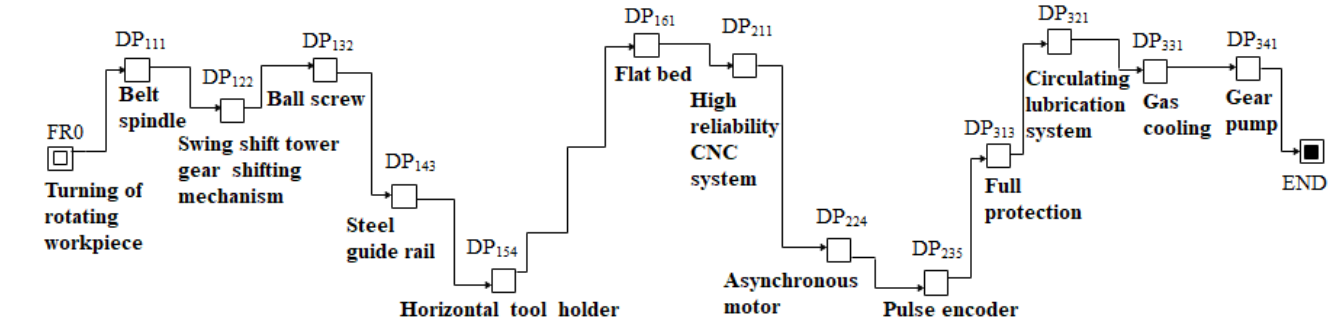
Figure 16. Optimal product design scheme while considering remanufacturability.